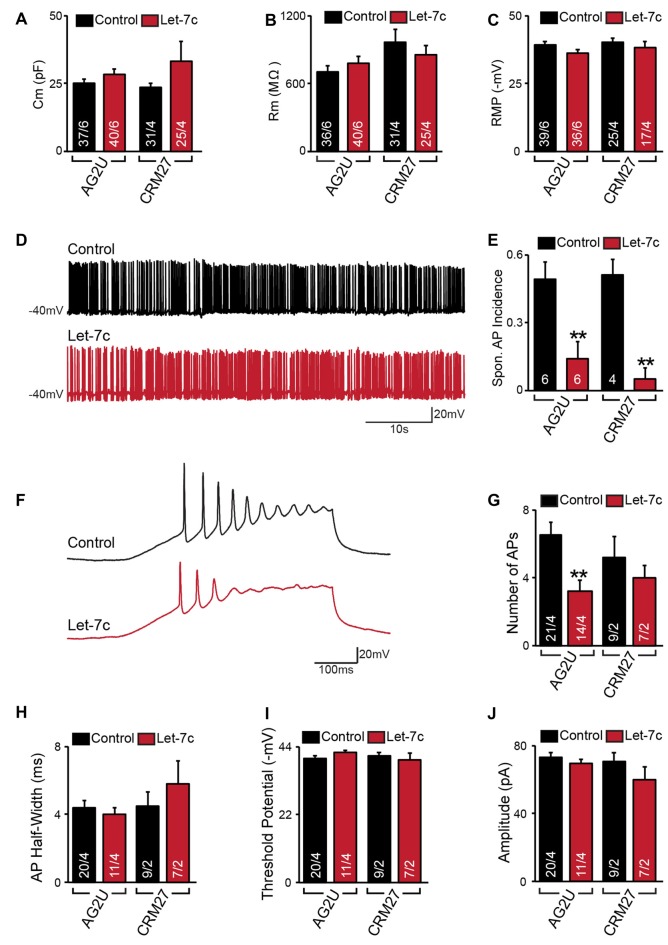
Hsa-let-7c overexpression reduces action potential (AP) firing. (A–C) let-7c overexpression did not alter membrane capacitance (A), membrane resistance (B), or Resting membrane potential (RMP) (C) of iN cells. (D,E) While iN cells overexpressing let-7c were capable of firing spontaneous APs (D), a significantly smaller proportion of cells fired spontaneous APs (Spon. AP) compared to controls (E). (F,G) iN cells overexpressing let-7c fired fewer APs per ramp compared to controls. (H–J) let-7c overexpression did not change the half-width (H), threshold potential (I), or peak amplitude (J) of APs induced by current ramp, suggesting that the reduction in AP firing is likely due to a reduction in excitability rather than maturity. Statistical tests were performed using two-tailed Student’s t-test, where **p < 0.01.